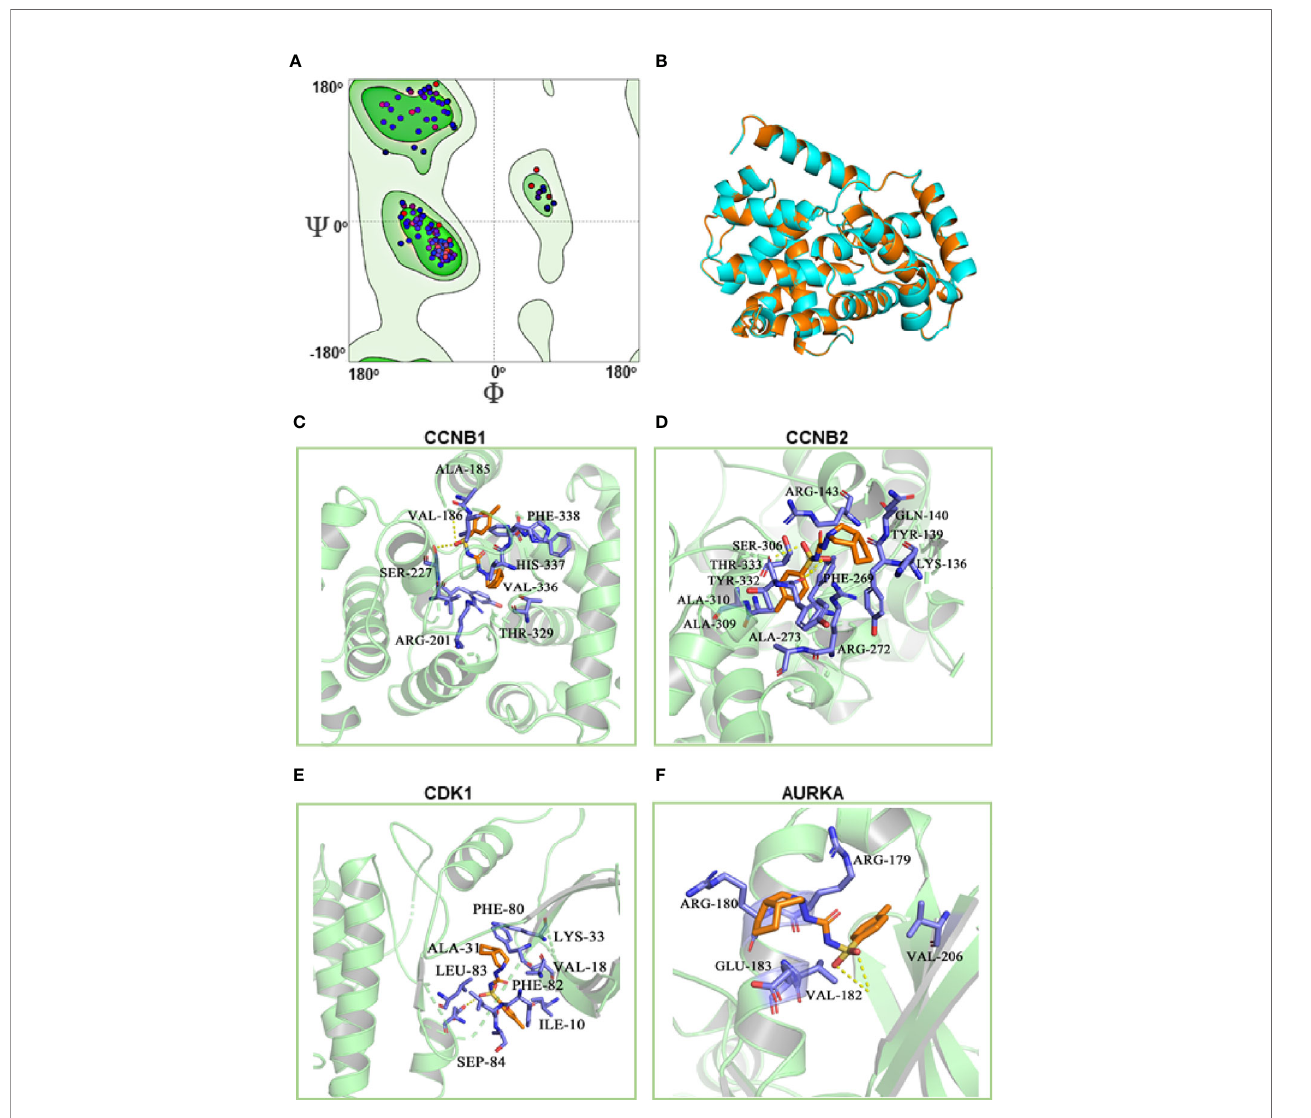
FIGURE 7 | Molecular docking of gliclazide targets. The results of CCNB2 homology modeling. Ramachandran plot analysis showed that existence of 98.4% of all residues in the allowed regions for CCNB2 (A) , the structure of CCNB2 was basically the same as that of template protein, and the identity of their amino acid sequence was 64.5%, highlighting the accuracy of the predicted structures (B) . (C – F) Molecular docking analyses for Gliclazide with target